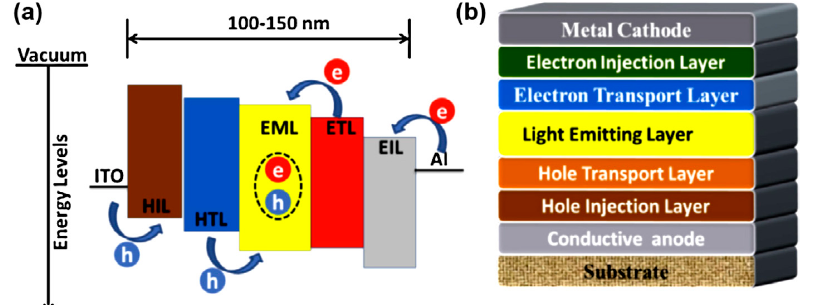
Figure 1. Typical device configuration of OLEDs. “Reprinted (adapted) with permission from Li, Y.; Liu, J.-Y.; Zhao, Y-D.; Cao, Y.-C. Mater. Today 2017 , 20 , 258–266. Copyright 2017 Elsevier [1]”.